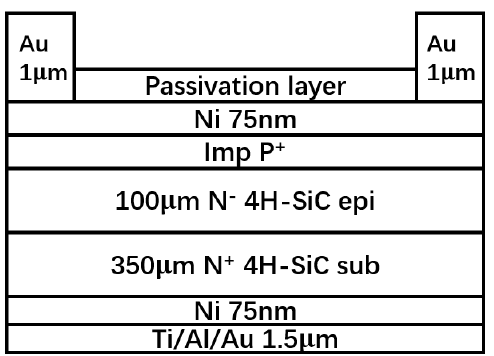
Figure 1. Cross section of planar 4H-SiC detector designed by NJU.